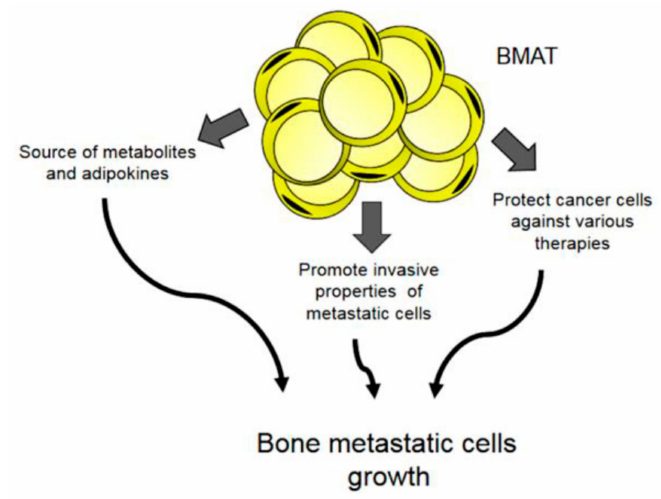
Figure 2. Potential contribution of BMAT to bone metastatic